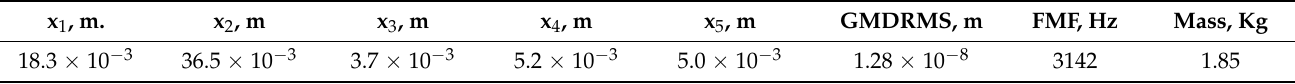
Figure 16. The Pareto frontier solution set optimized by BR-RNN-NSGA-II. Table 5. Final optimized design